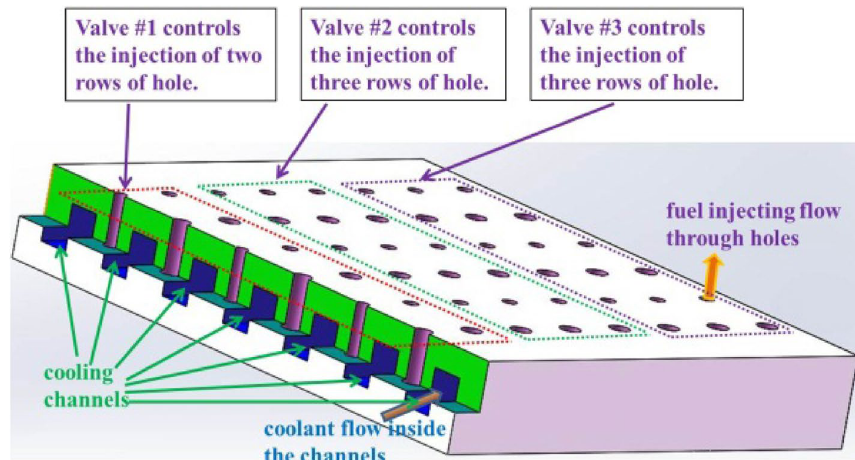
Fig. 5 Fuel injecting holes and cooling